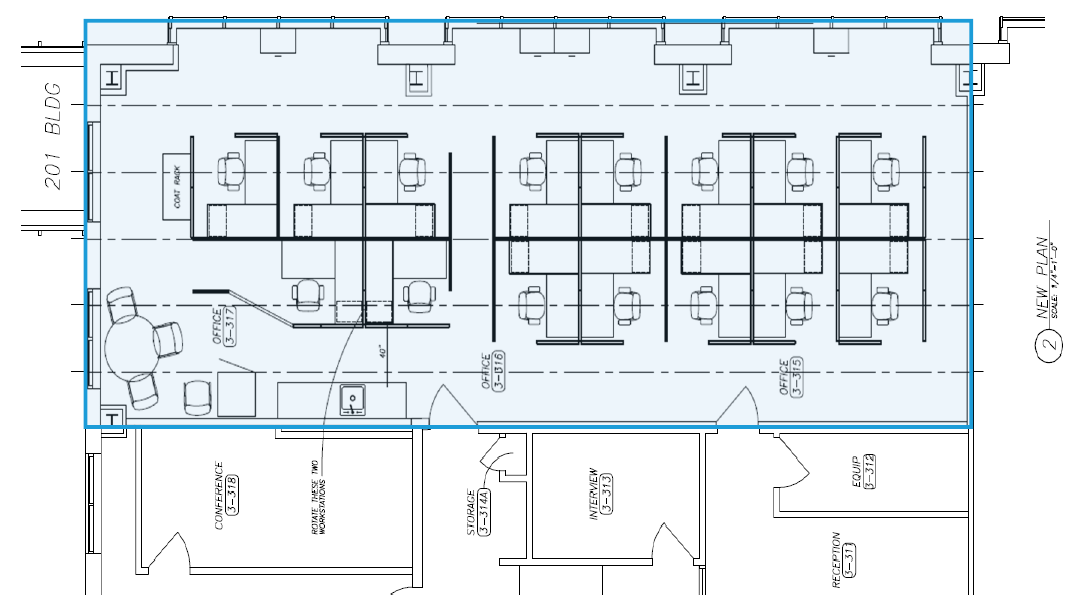
Figure 2. Floor plan of the study modules and desk layout.